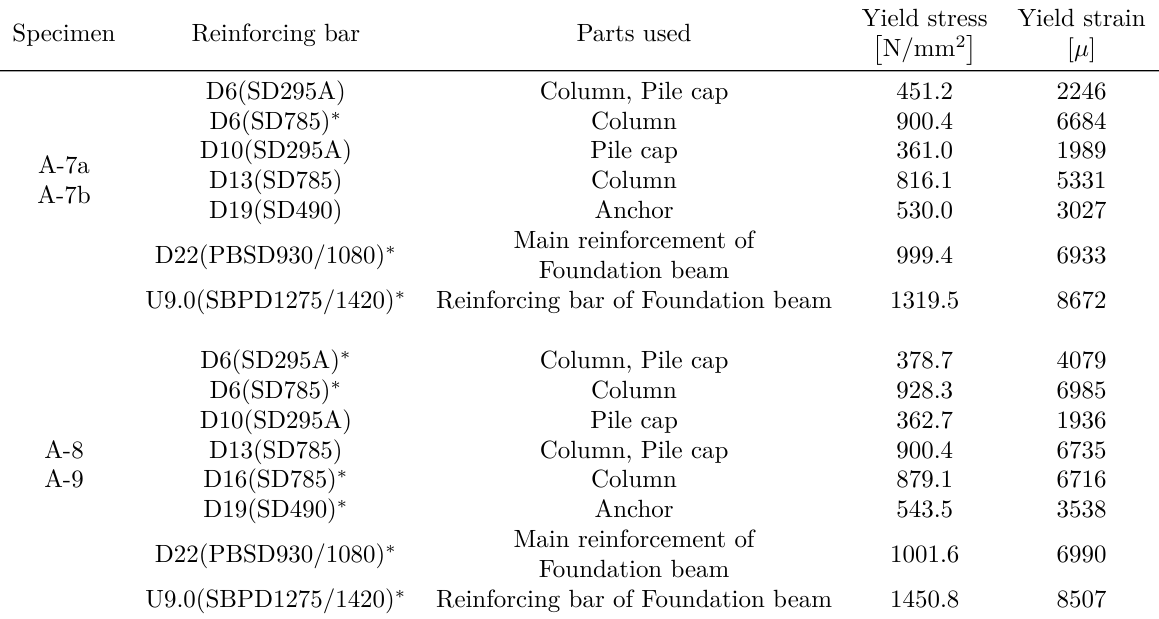
Table 2. Material Properties of Steel.